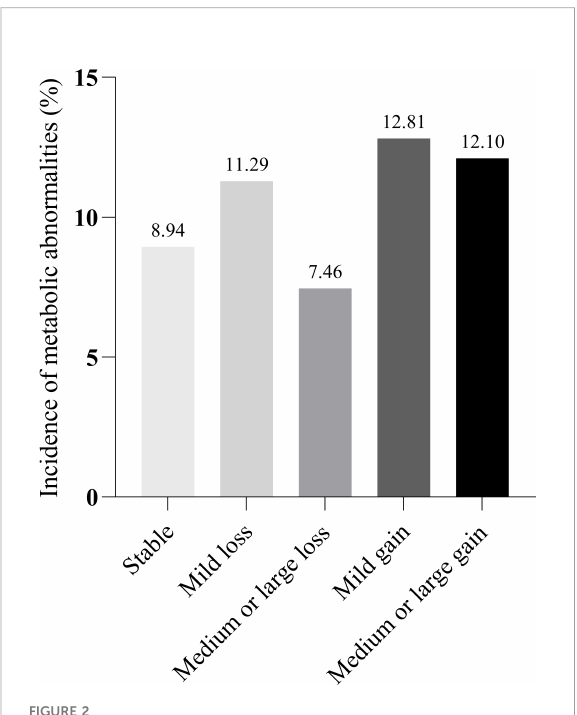
FIGURE 2 Incidence of metabolic abnormalities by weight change